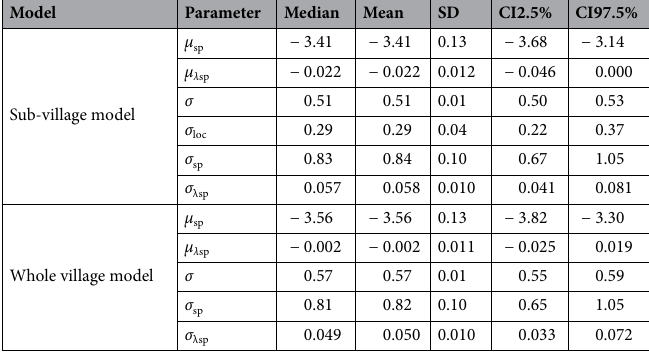
Table 2. Posterior distribution of parameters of two